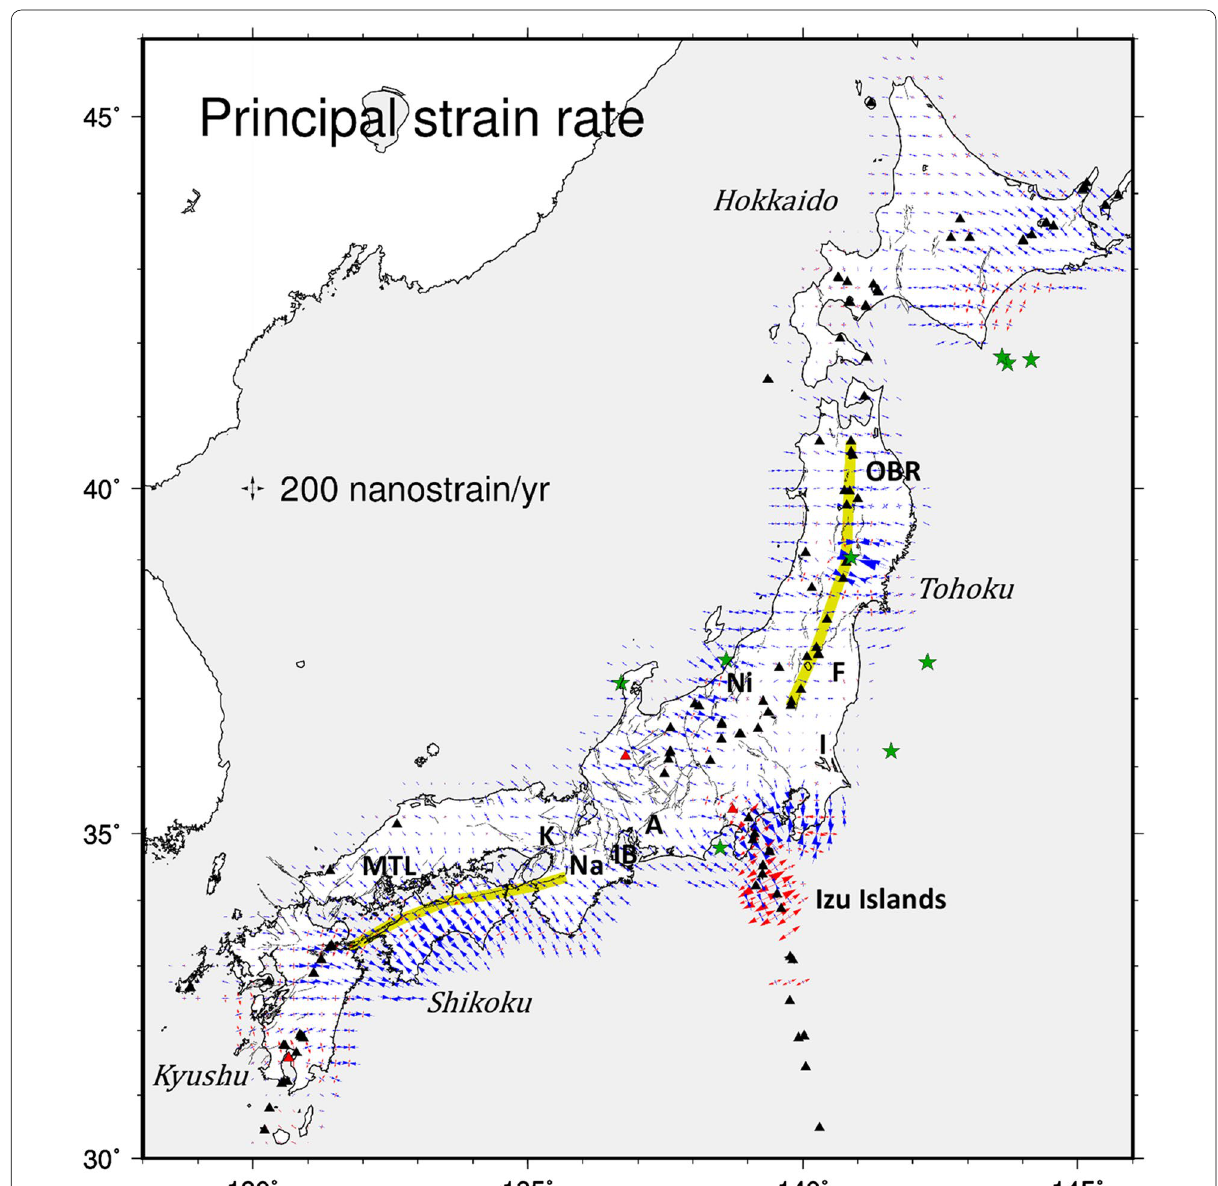
Fig. 15 The principal axes of the strain-rate field estimated using the ABIC method with L = 20 km. Red and blue arrows represent expansive and contractive strain rates, respectively. Green stars represent the epicenters of earthquakes whose coordinate offsets are removed from GNSS data. Yellow lines trace MTL and OBR. Black lines represent surface traces of major active faults (Headquarters for Earthquake Research Promotion 2017). Red triangles represent Mt. Fuji, Hakusan and Sakurajima, and black triangles represent other active volcanos (JMA 2013). The following acronyms are used: MTL Median Tectonic Line active fault system, OBR Ou Backbone Range, IB Ise Bay, A Aichi, F Fukushima, I Ibaraki, K Kobe, Na Nara, Ni